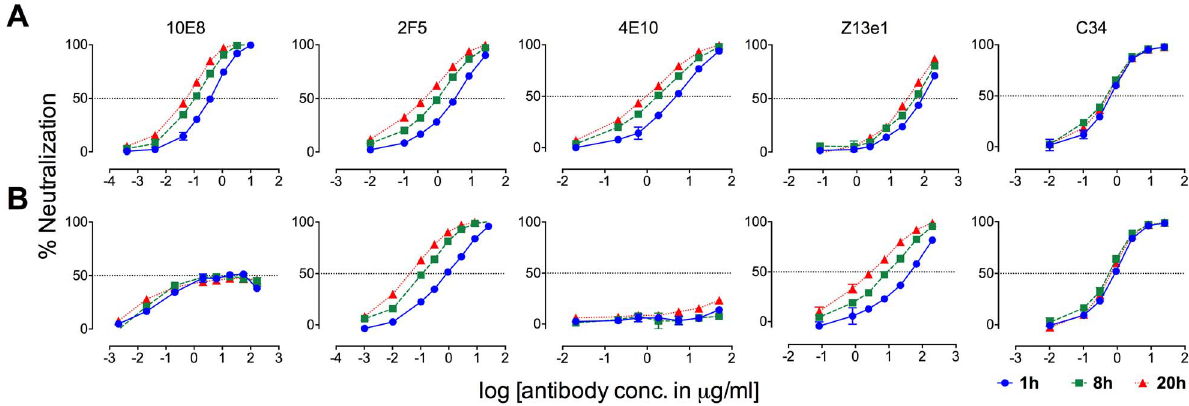
Figure 11. Kinetics of neutralization of JR2 F673L mutant by 10E8 and C34. ( A ) Wild type JR2 and ( B ) mutant F673L were incubated with MPER antibodies or fusion inhibitor C34 to the NHR of gp41 over a time course at 37 u C before adding onto target (TZM-bl) cells.